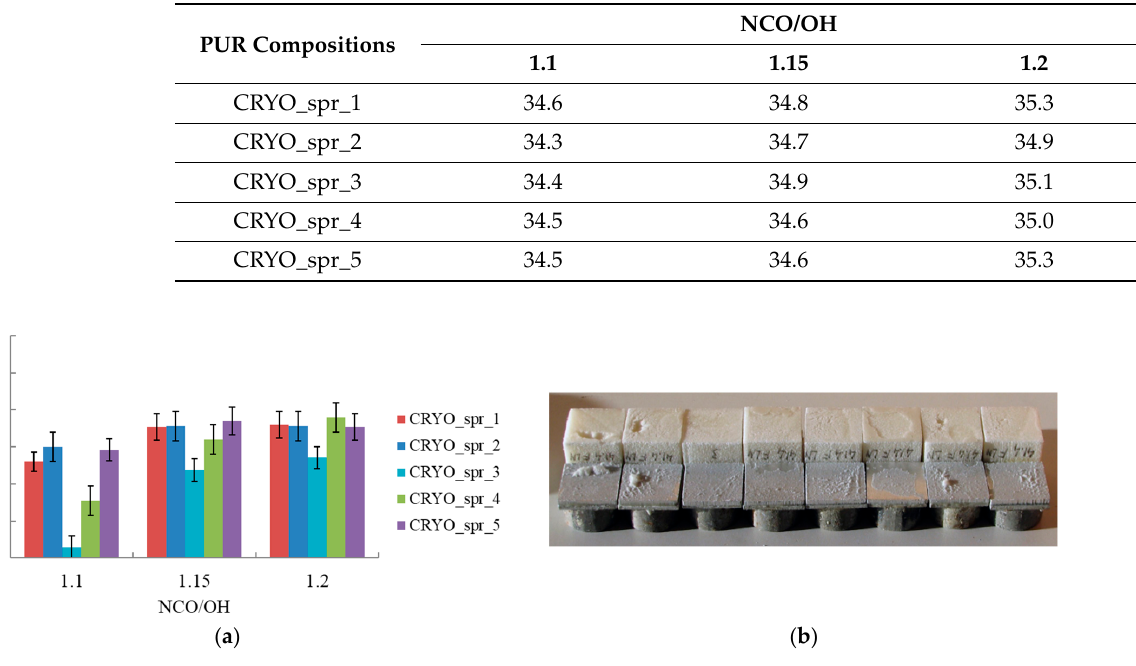
Figure 3. ( a ) Tensile bond strength of sprayed PUR foams after cryoshock test vs. NCO/OH ratio. ( b ) Sprayed PUR samples after cryoshock and tensile bond strength test.